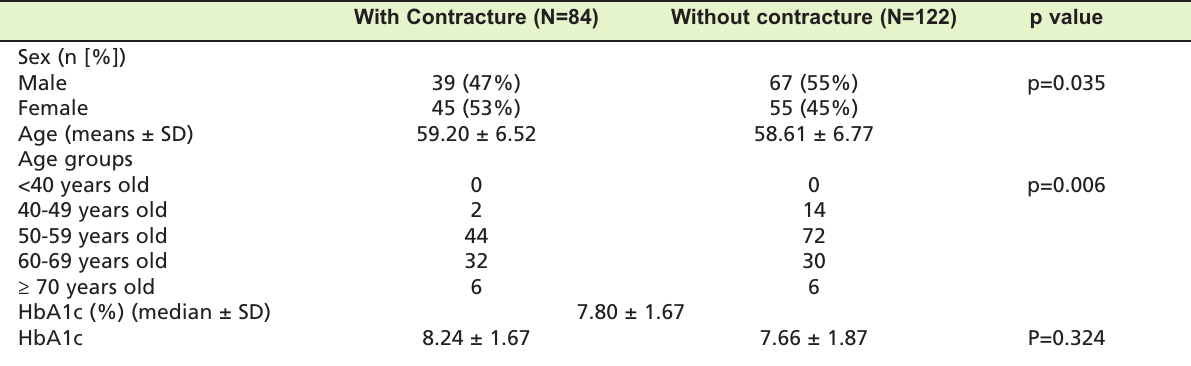
Patients characteristics and statistical analysis result Table I: With Contracture